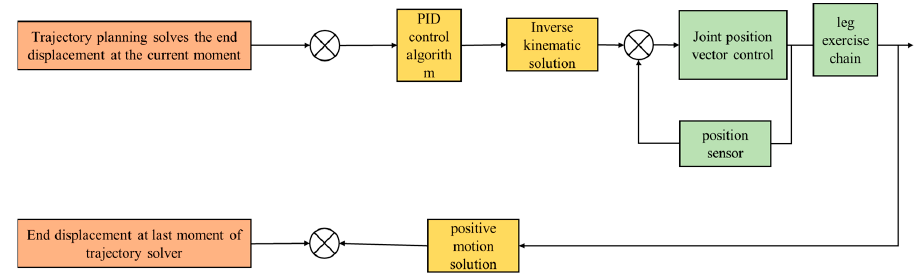
Figure 2. Block diagram of the principal structure of position